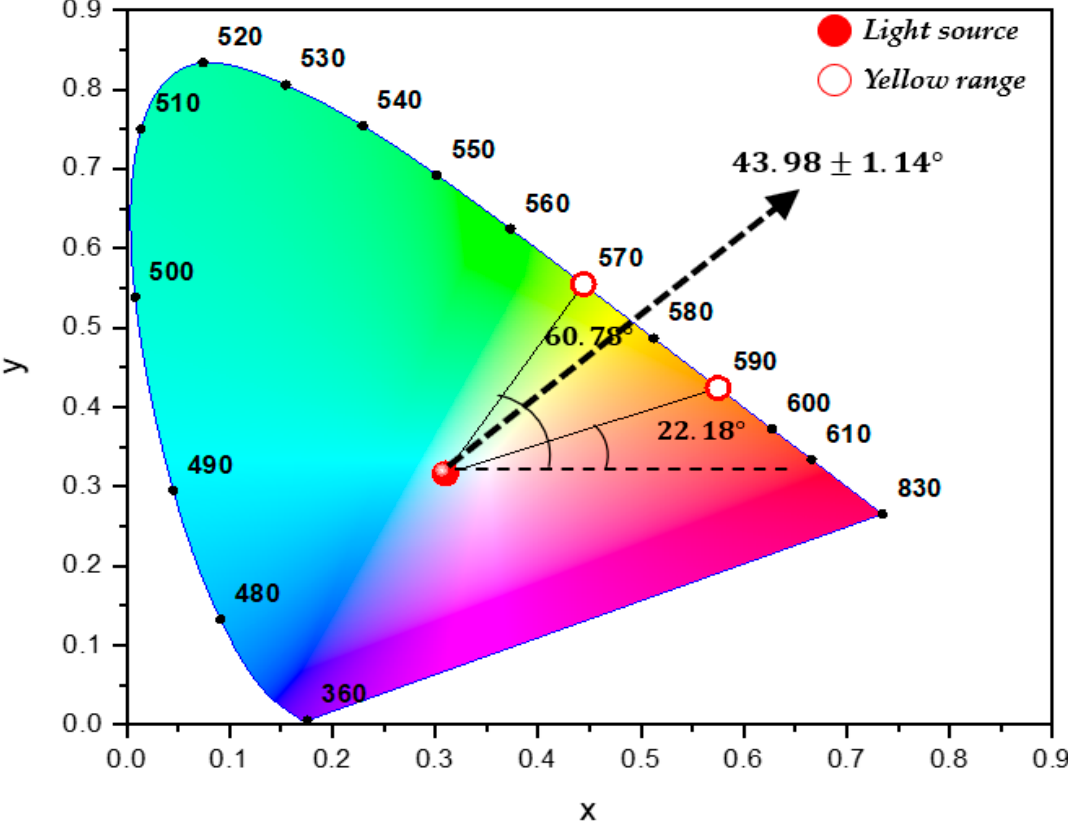
Figure 9. The representation of color shift from direct transmittance at 3 measurement locations (yellow range is shown in CIE1931 xy color diagram).